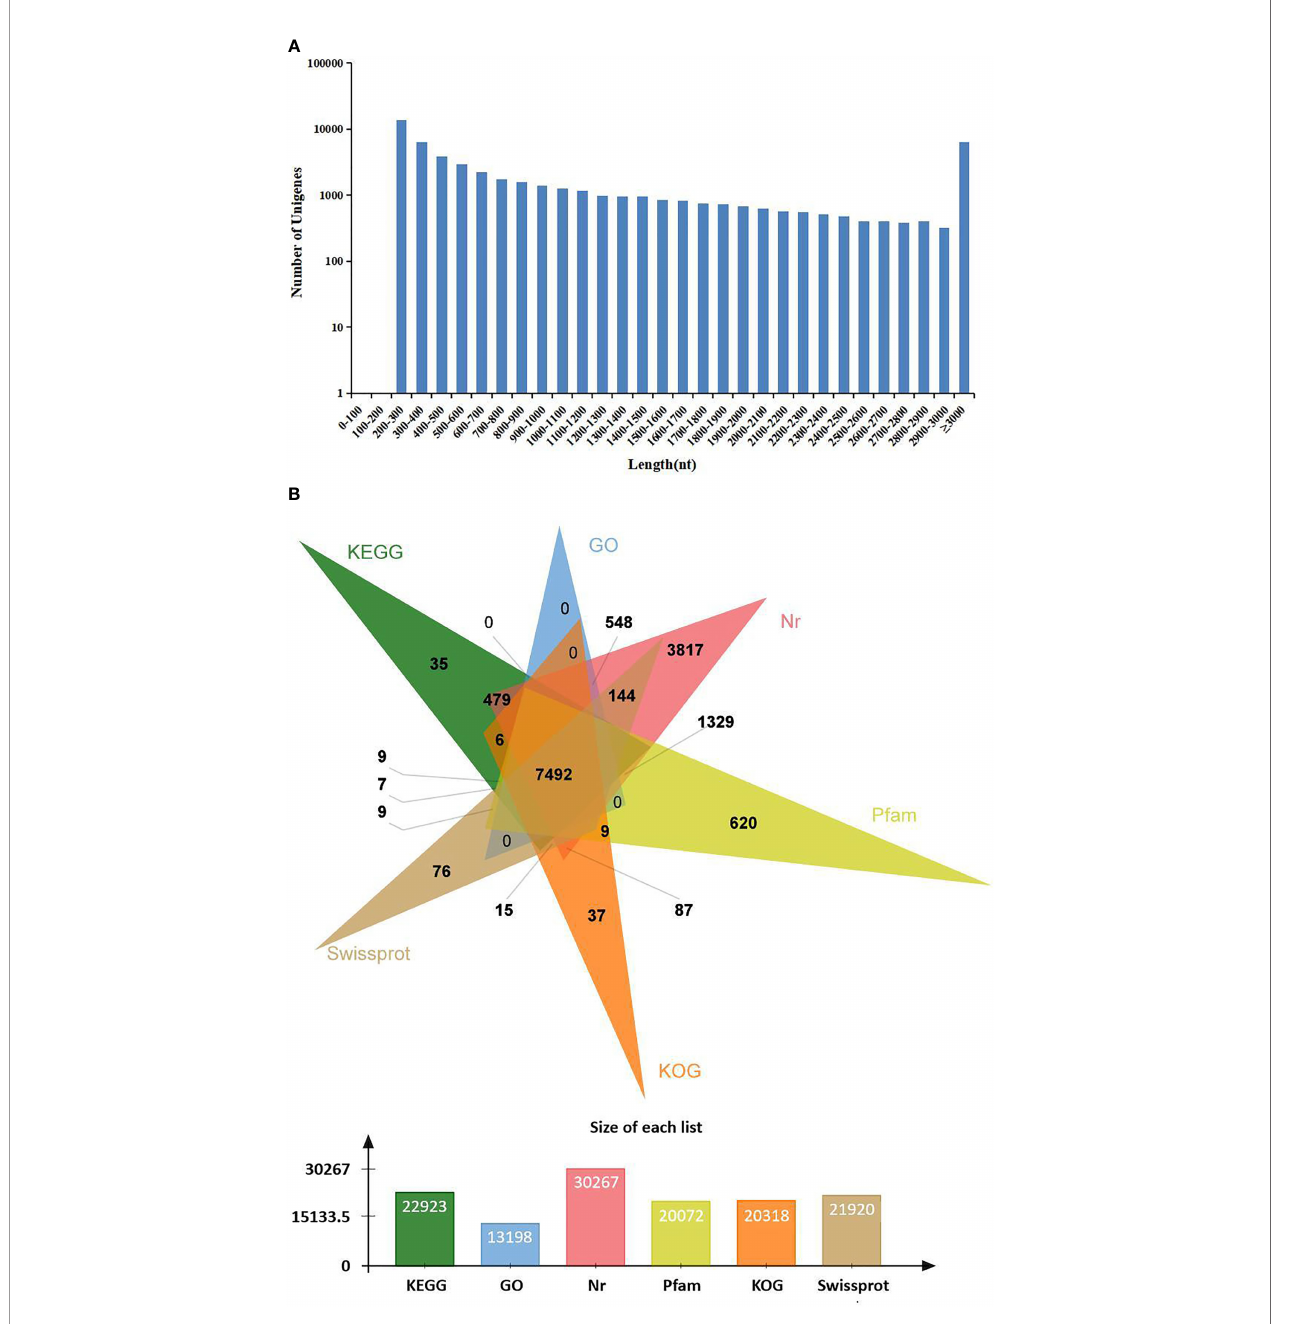
FIGURE 1 | Length distribution and annotation of transcriptome unigenes. (A) Length distribution of transcriptome unigenes. The x-axis indicates the length of unigenes, and the y-axis indicates the number of unigenes. (B) Annotation of transcriptome unigenes. The Venn diagram shows the annotation of unigenes from the Marsupenaeus japonicus transcriptome in 6 databases, including the KEGG, GO, KOG, Nr, Pfam, and SwissProt databases. KEGG, Kyoto Encyclopedia of Genes and Genomes; GO, Gene